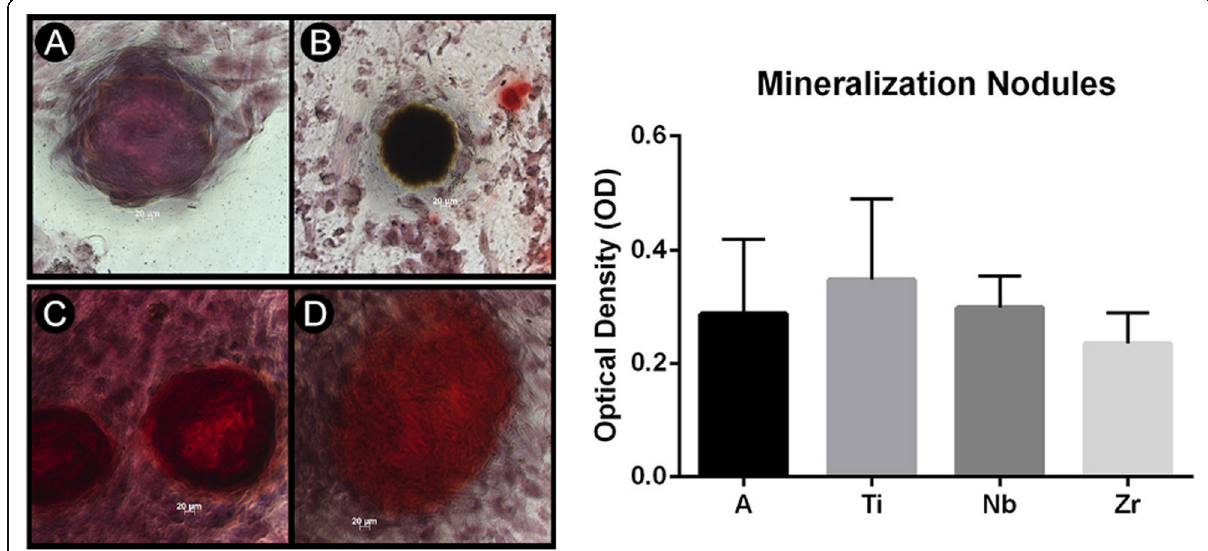
Fig. 6 Mineralized eosinophilic nodules can be observed in all the groups. a Titanium alloy, b pure titanium, c Nb, and d Zr. The quantification of the mineralization nodules is shown by the graph. The Ti group presented the highest result and the Zr group the lowest. No statistical differences were found between